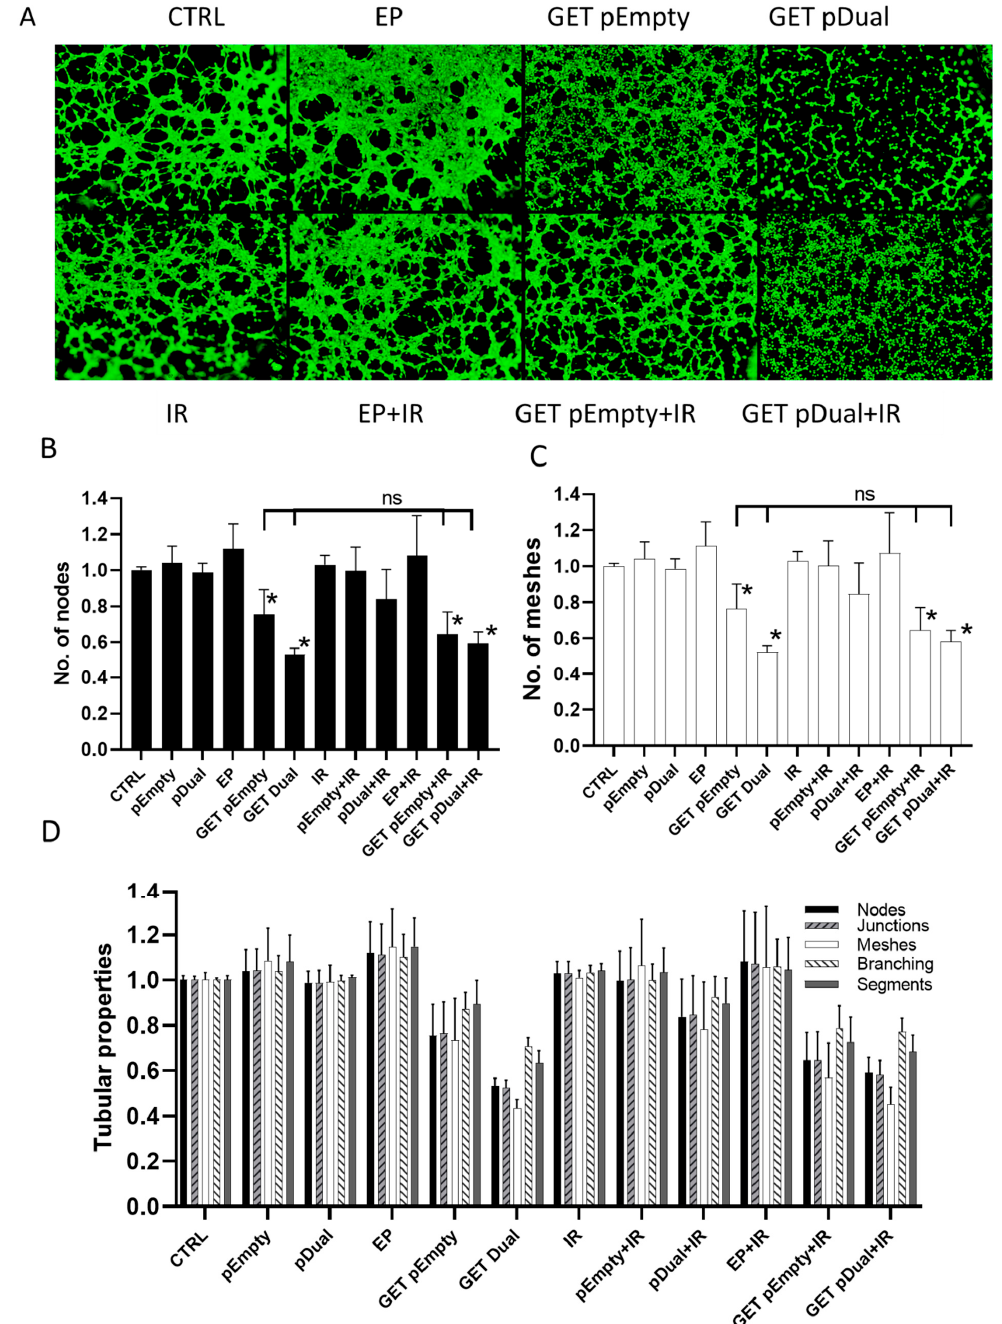
Figure 3. The effect of pU6-anti-CD105-146-ORT gene GET alone or in combination with IR on the capillary tube formation. ( A ) Representative images of 2H-11 tubular complexes after pU6-anti-CD105-146-ORT GET and IR. ( B ) Number of 2H-11 nodes after pU6-anti-CD105-146-ORT GET and IR. ( C ) Number of 2H-11 meshes after pU6-anti-CD105-146-ORT GET and IR. ( D ) Various 2H-11 tubular properties after pU6-anti-CD105-146-ORT GET and IR. Bars represent the mean ± standard error of mean for three independent experiments. Values are normalized to the control group. *, statistically significant difference vs. all groups ( p < 0.05). ns, statistically non-significant difference. Scale bar = 500 µ m. Group names: CTRL— untreated cells, pEmpty—treatment with pEmpty-ORT plasmid alone, pDual—treatment with pU6-anti-CD105-146-ORT plasmid alone, EP—application of electric pulses alone, GET pEmpty—GET of pEmpty-ORT plasmid, GET pDual—GET of pU6-anti-CD105-146-ORT plasmid, IR—IR with 5 Gy, EP + IR—application EP and IR with 5 Gy, GET pEmpty + IR—GET